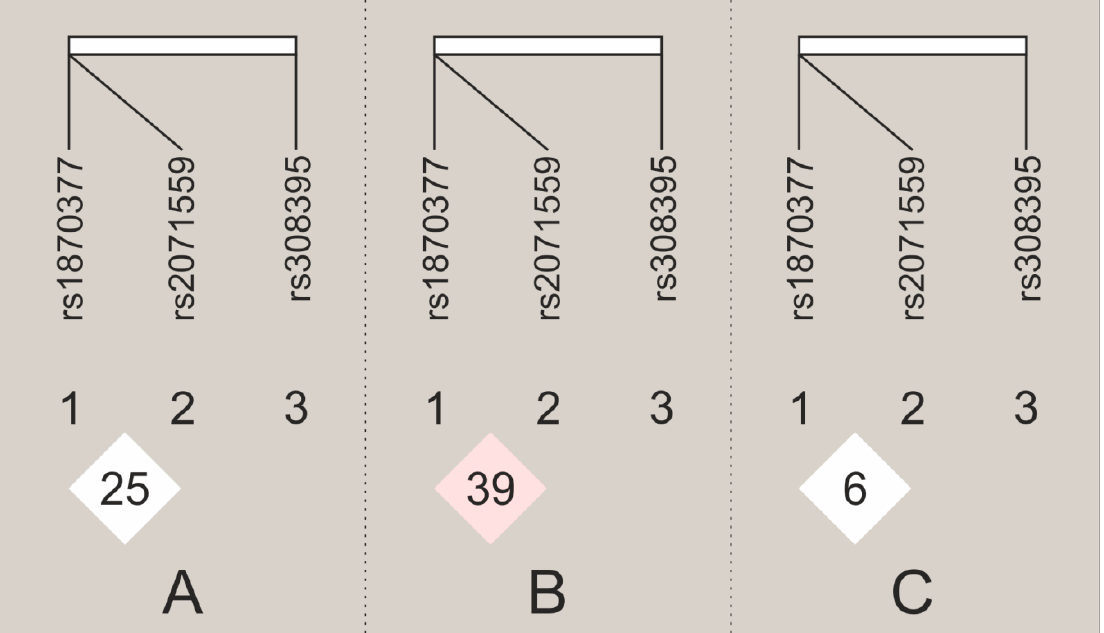
Figure 1. Linkage disequilibrium (LD) maps of the KDR and FGF2 gene polymorphisms for all study women ( A ), cases ( B ) and controls ( C ). The map illustrates the pairwise LD between SNPs based on D ′ values. The numbers in the triangles represent the D’ *100 between the adjacent SNPs.